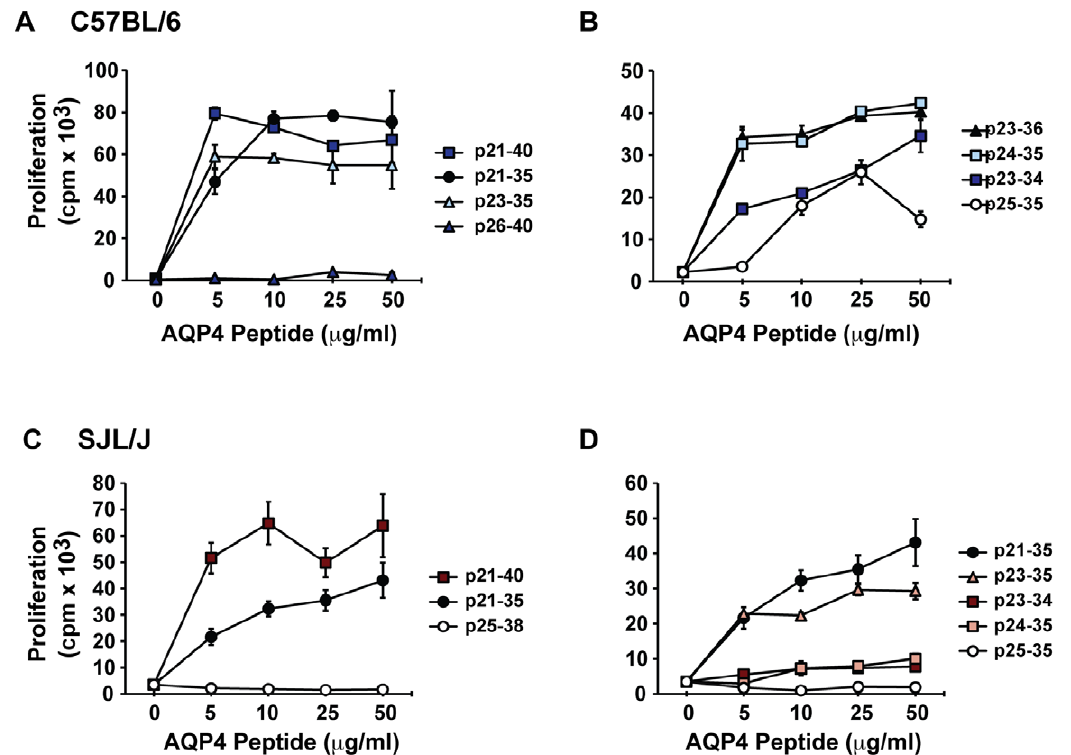
Figure 5. Characterization of the minimal core T cell epitope within AQP4 p21-40. AQP4 p21-40-specific T cells were restimulated with truncated peptides to determine the core of the p21-40 determinant in (A, B) p21-40 specific C57BL/6 cell lines and (C, D) p21-40 specific SJL/J primary lymph node cells. Cell lines were restimulated with irradiated syngeneic splenic APC and various concentrations of p21-40 or truncated peptides. After 48 hours (cell lines) or 72 hours (LN), cultures were pulsed with 3 H-thymidine and harvested 16 hours later. Data shown represent means of triplicates + / 2 SEM.